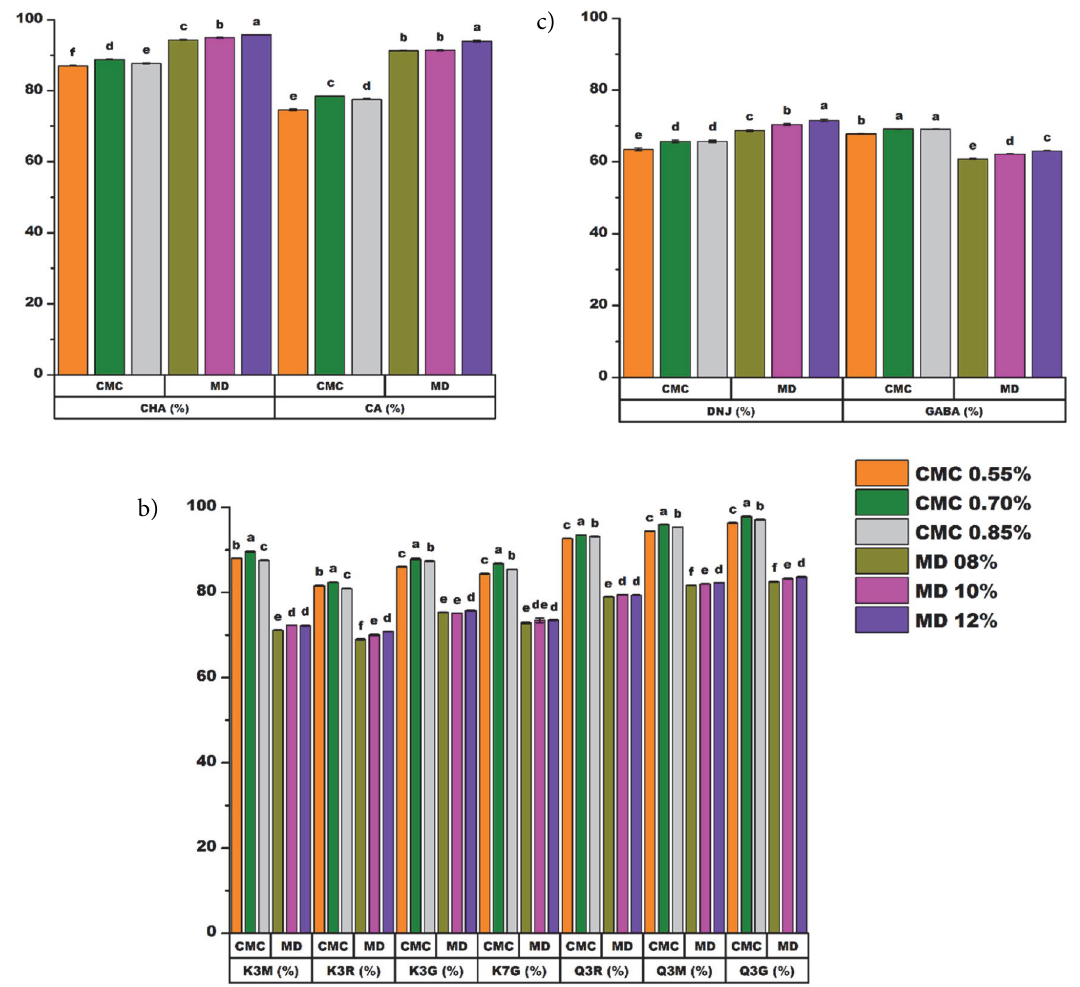
Figure 2 . Phenolic acids (a), flavonols (b), and other nutraceutical compounds (c) encapsulation efficiency of encapsulated freeze-dried mulberry leaf extract powders CHA-chlorogenic acid, CA-caffeic acid, K3G-kaempferol-3-glucoside, K3M-kaempferol-3-(6-malonylglucoside), K3R-kaempferol-3-(6-rhamno- sylglucoside), K7G- kaempferol-7-O-glucoside, Q3G-quercetin-3-O-glucoside, Q3M-quercetin-3-(6-malonylglucoside), Q3R-quercetin-3-ru- tinose, DNJ-1-deoxynojirimycin, GABA-gamma-aminobutyric acid, CMC- sodium carboxymethyl cellulose, and